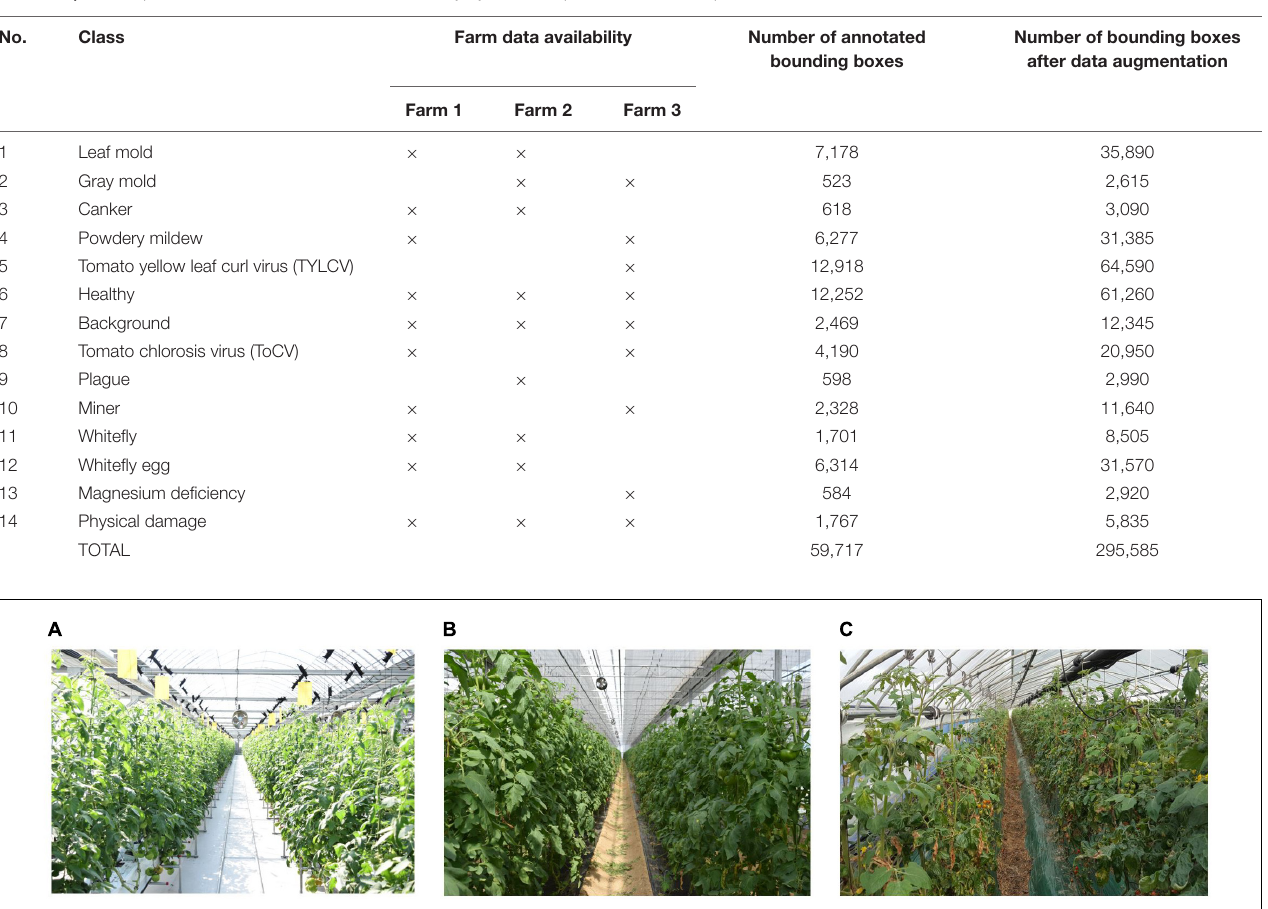
TABLE 1 | Tomato plant diseases dataset and data availability by farm for open set domain